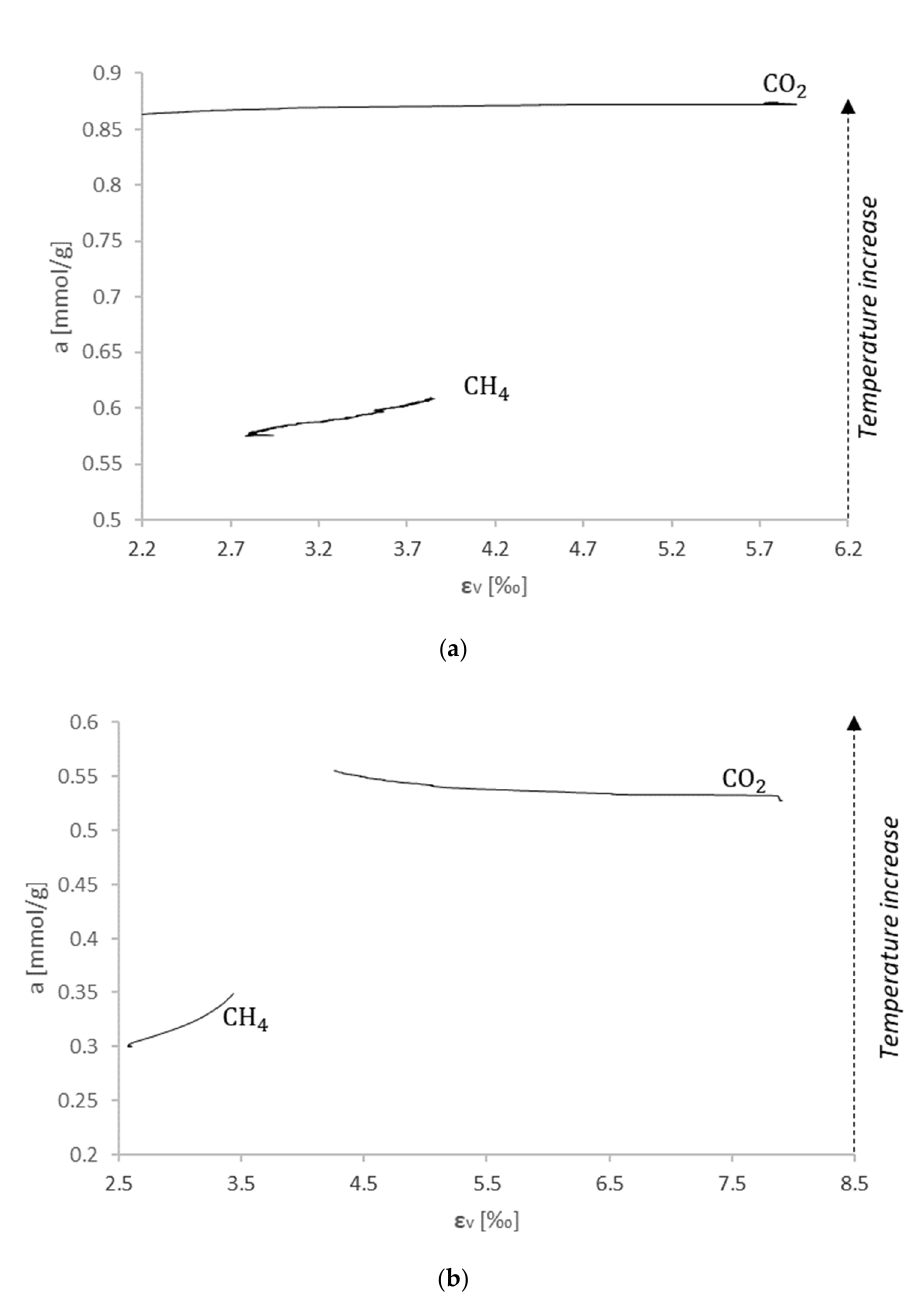
Figure 7. ( a ) Relationship between the amount of sorbed vapours and gases and the volumetric strain for sample P1 under non-isothermic conditions. ( b ) Relationship between the amount of sorbed vapours and gases and the volumetric strain for sample P2 under non-isothermic conditions.